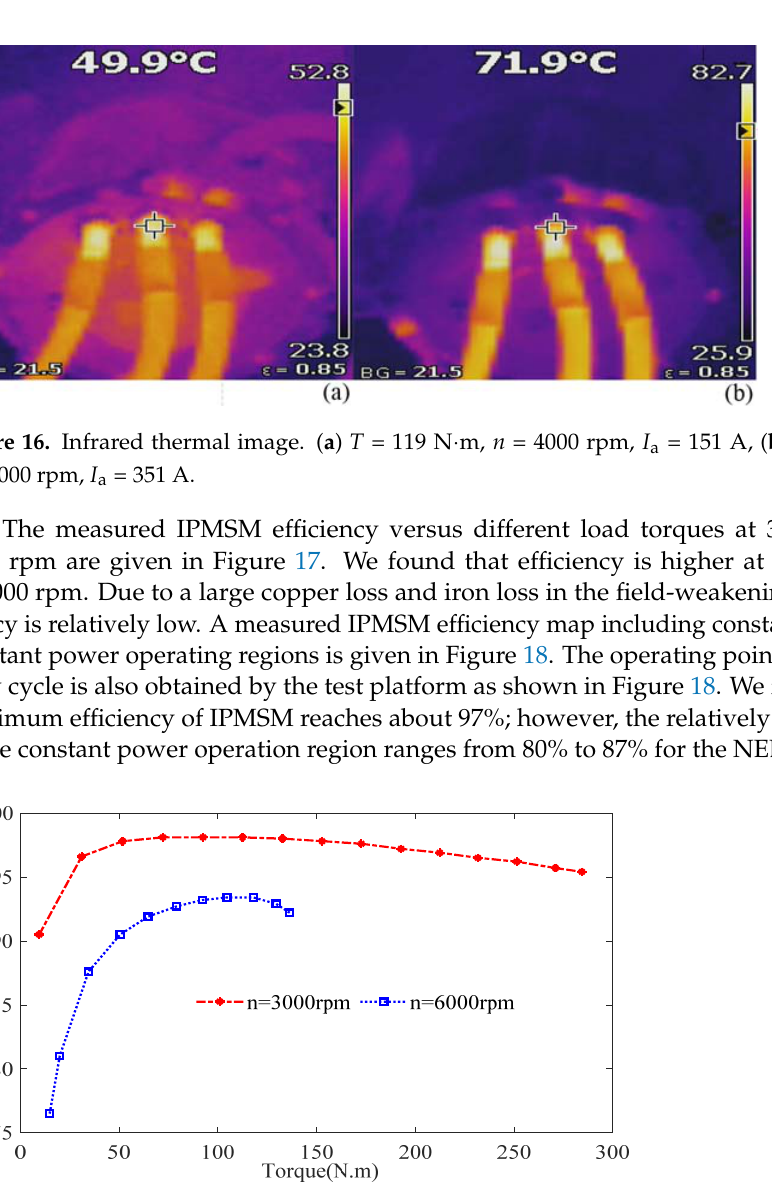
15 of 17 Figure 15. Phase current wave. ( A ) rated load, ( B ) overload.